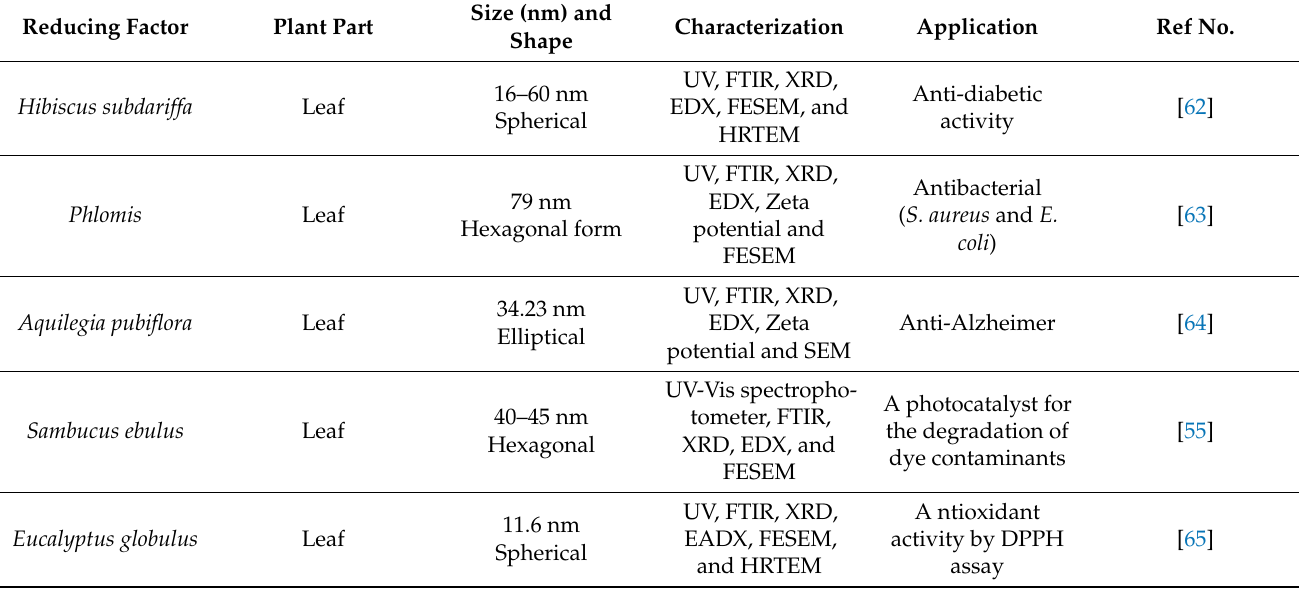
Table 1. A variety of plant parts were utilized to synthesize zinc